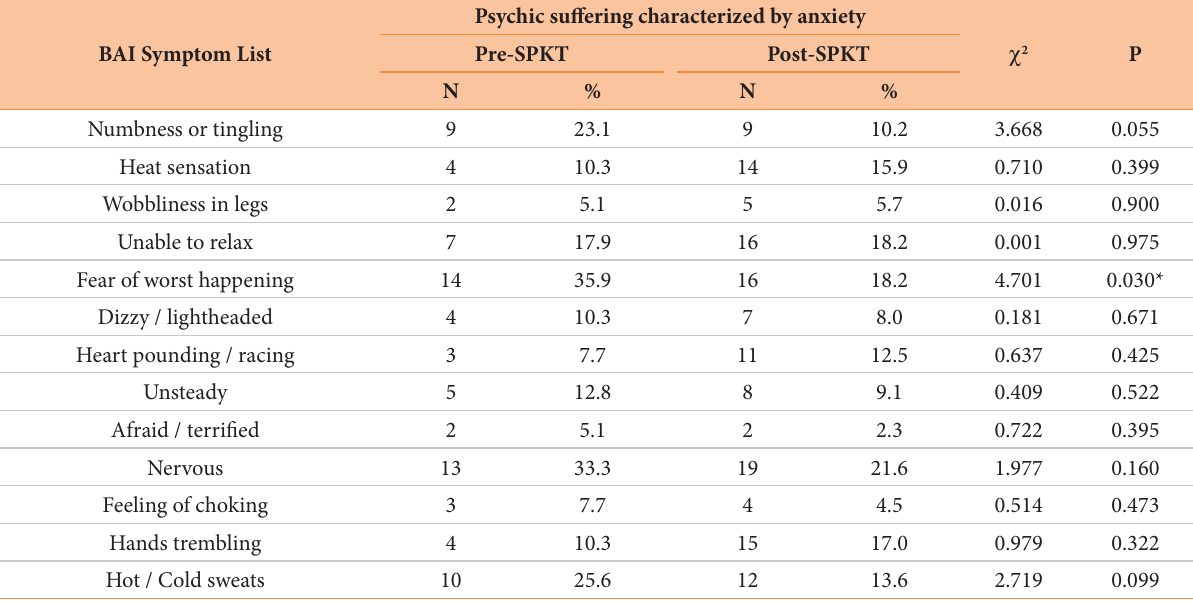
Table 5 - Comparison of the 21 variables related to the BAI psychological test between the pre- and post-SPKT